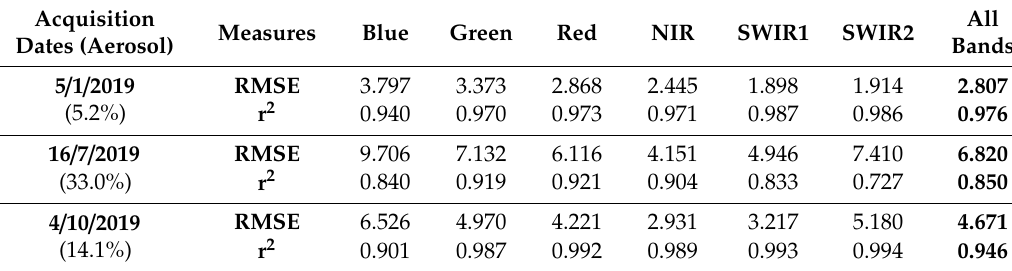
Table 3. Band-by-band RMSE (% reflectance units) and coe ffi cient of determination (r 2 ) between high-level aerosol (SR aerosol) on the SS2 for each date is shown in the first column between brackets.